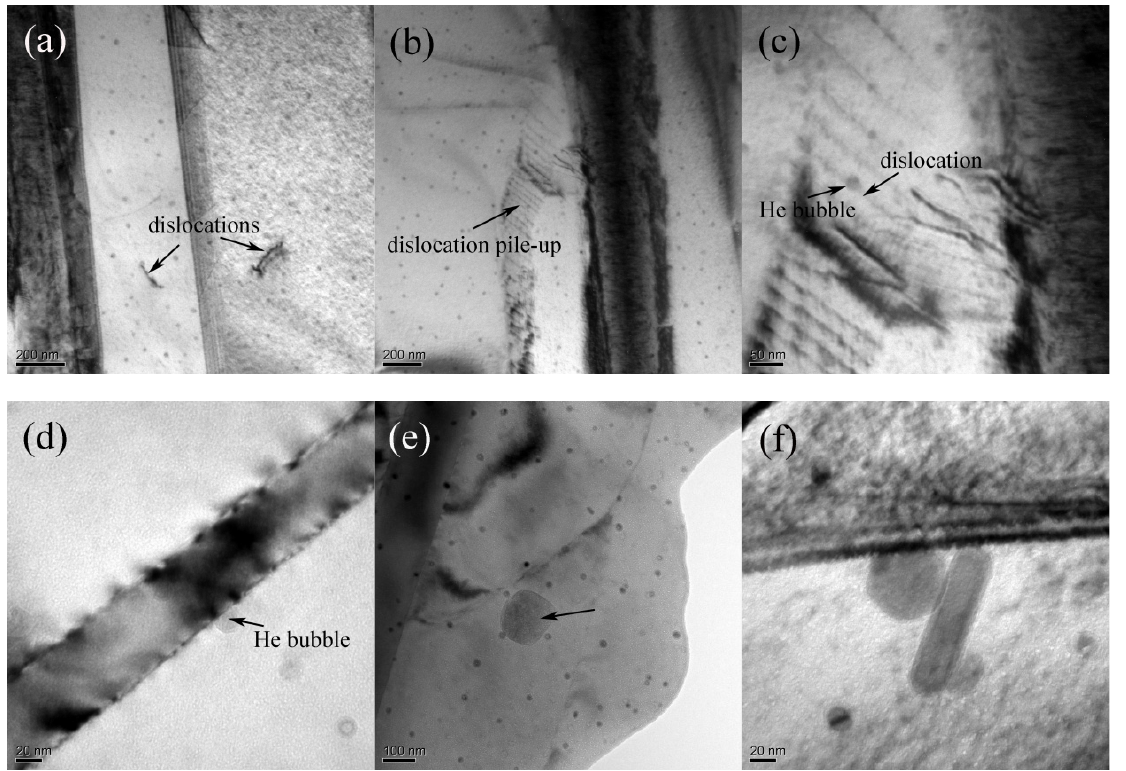
Figure 5. TEM images of irradiation-induced dislocations ( a , b ), helium bubbles nucleate on dislo- cations ( c ) and boundaries ( d ), and growth ( e , f ) after He ion implantation at 773